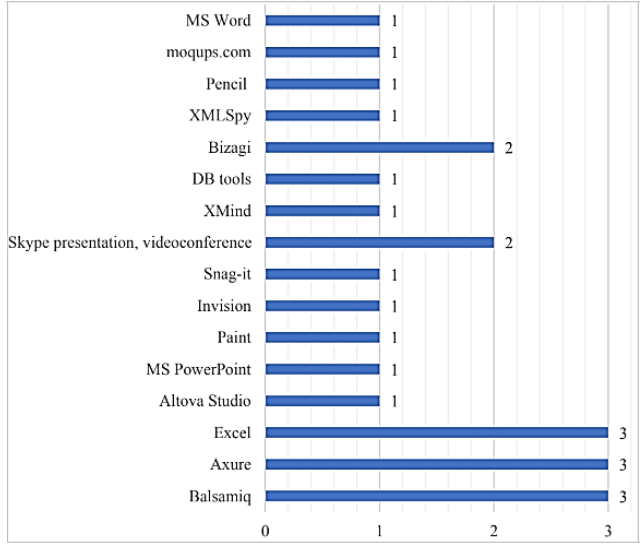
Fig. 9. Tools mentioned by experts in their